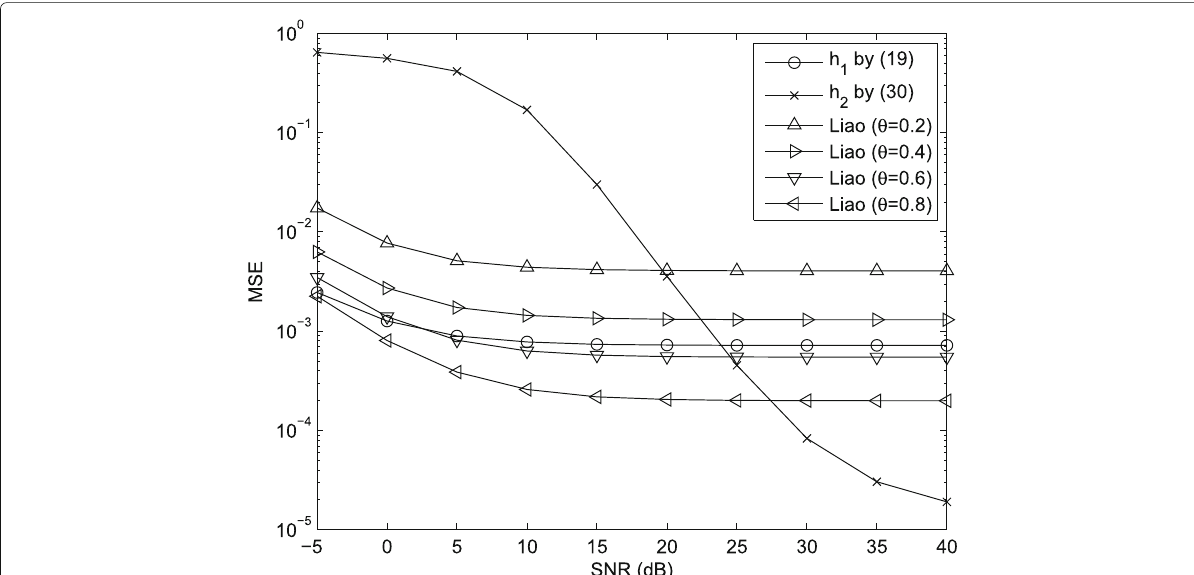
Fig. 4 Comparison of the normalized MSE for K = 500. We compare the normalized MSE performances of our method with the method proposed by Liao et al. in [34]. The parameter θ in Liao’s algorithm is set to 0.2, 0.4, 0.6, and 0.8. The number of received blocks is K =